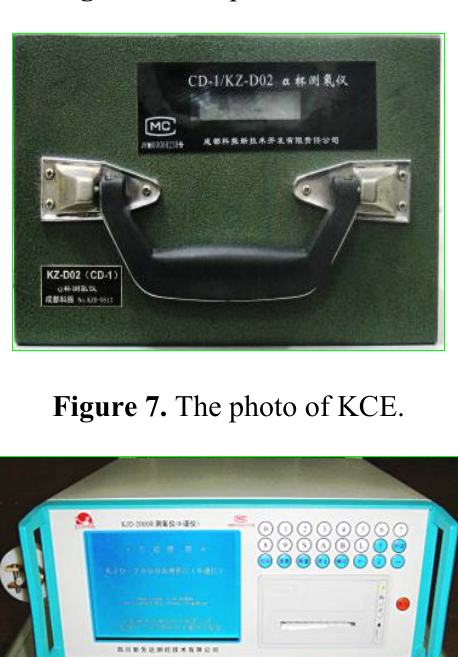
Figure 6. The photo of CCE.